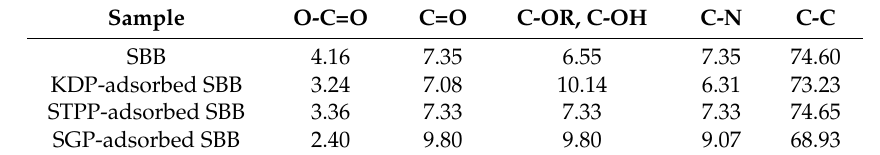
Table 4. Relative contents of surface functional groups (Atomic %) estimated by fitting C1s XPS spectra.